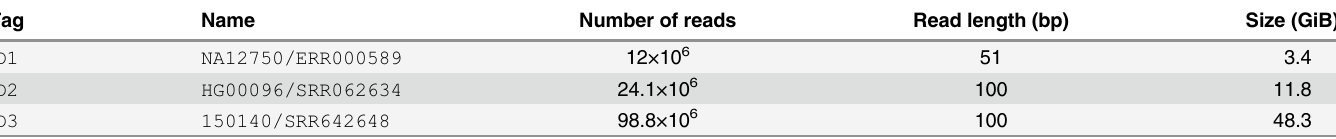
Table 2. Main characteristics of the input datasets from the 1000 Genomes